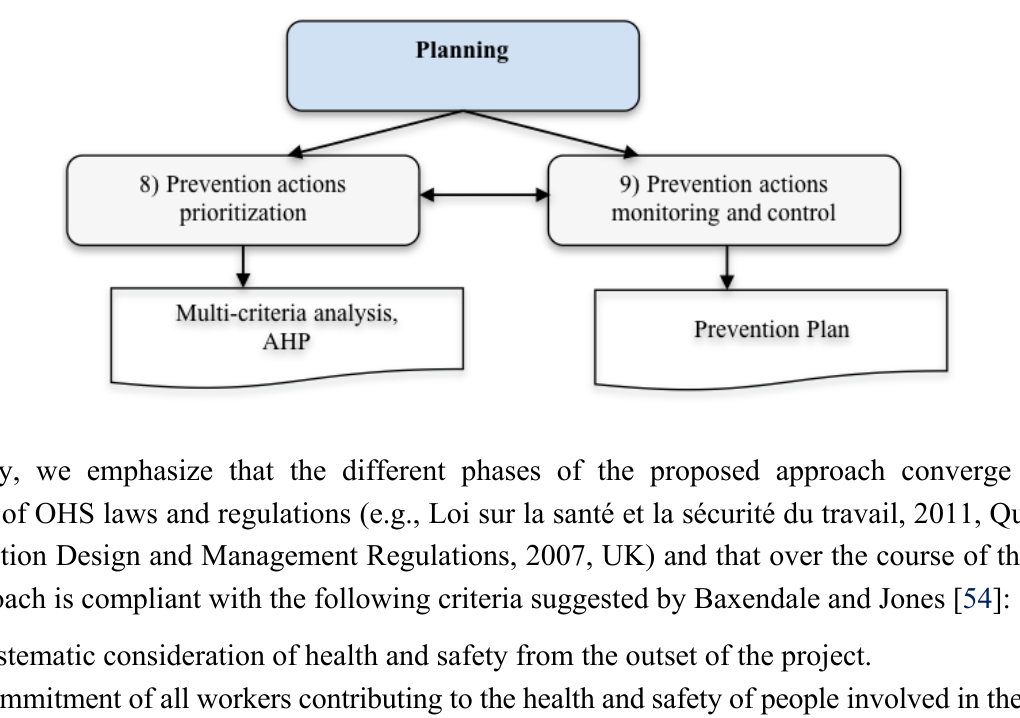
Figure 5. Planning phase of the risk-factor-based